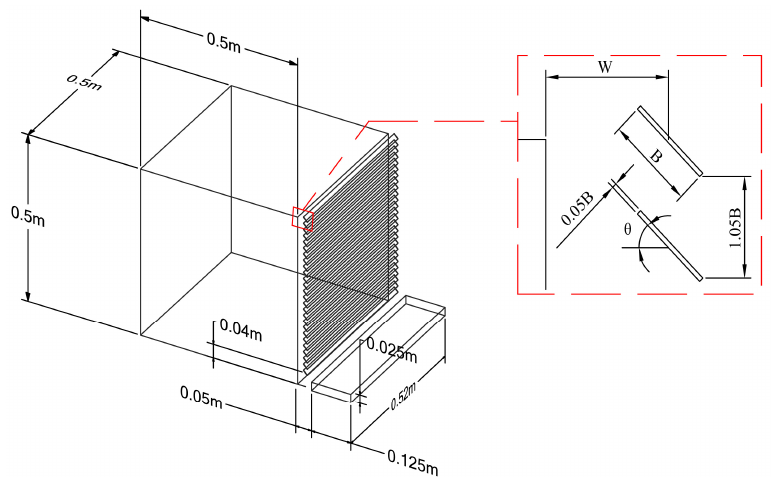
Figure 2. Geometry model of the cube building with shading louvers.